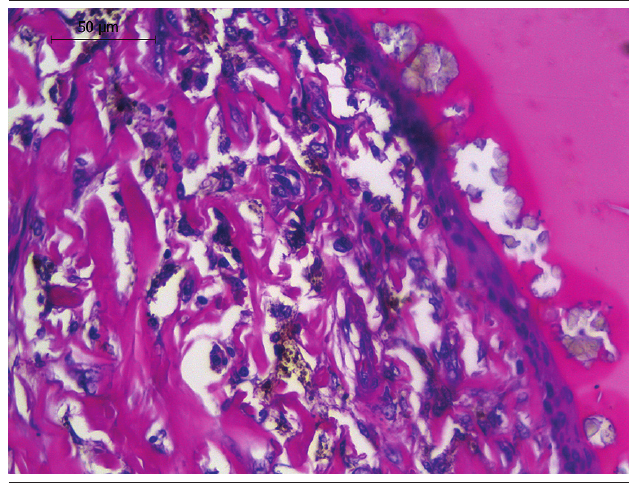
fIgure 2 – Higher magnification showing the limit between the fibrohistiocytic stroma and the wall of a glandular structure composed by layers of a non-keratinizing squamous epithelium. Note the presence of hemosiderin inside the cells (HE, 400×) HE: hematoxylin and